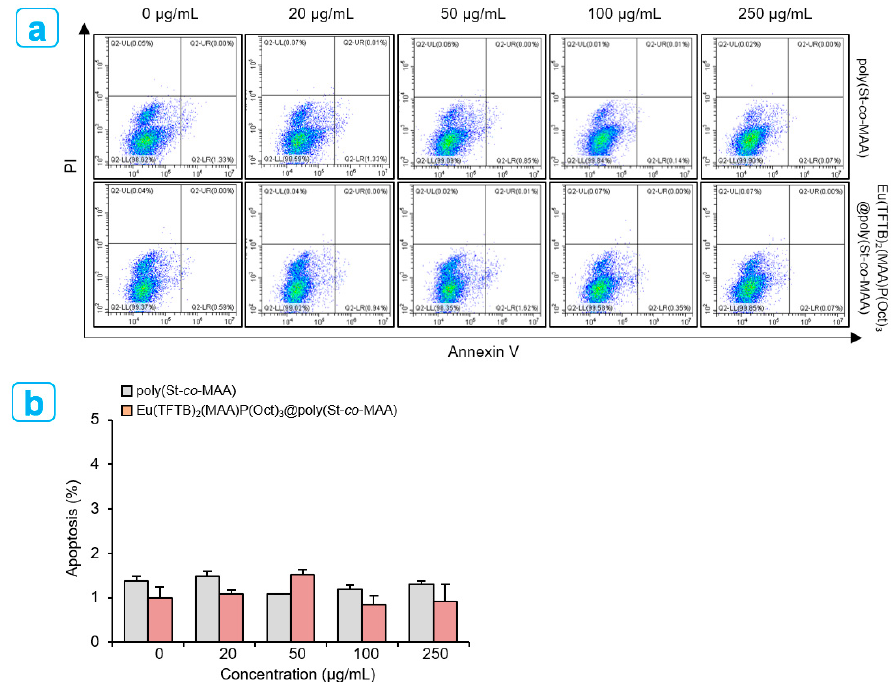
Figure 9. ( a ) Concentration-dependent cell viability of HepG2 cells treated with 20, 50, 100 and 250 µ g/mL of poly(St- co -MAA) and Eu(TFTB) 2 (MAA)P(Oct) 3 @poly(St- co -MAA) nanoparticles for 24 h. The cells were stained with Annexin V-FITC and quantified for apoptosis by flow cytometer. Top right quadrant, dead cells in late stage of apoptosis; bottom right quadrant, cells undergoing apoptosis; bottom left quadrant, viable cells. ( b ) The rate of apoptosis depends on the concentration of poly(St- co -MAA) and Eu(TFTB) 2 (MAA)P(Oct) 3 @poly(St- co -MAA) nanoparticles. Data are shown as means ± SEM. Results are representative of at least three independent experiments.